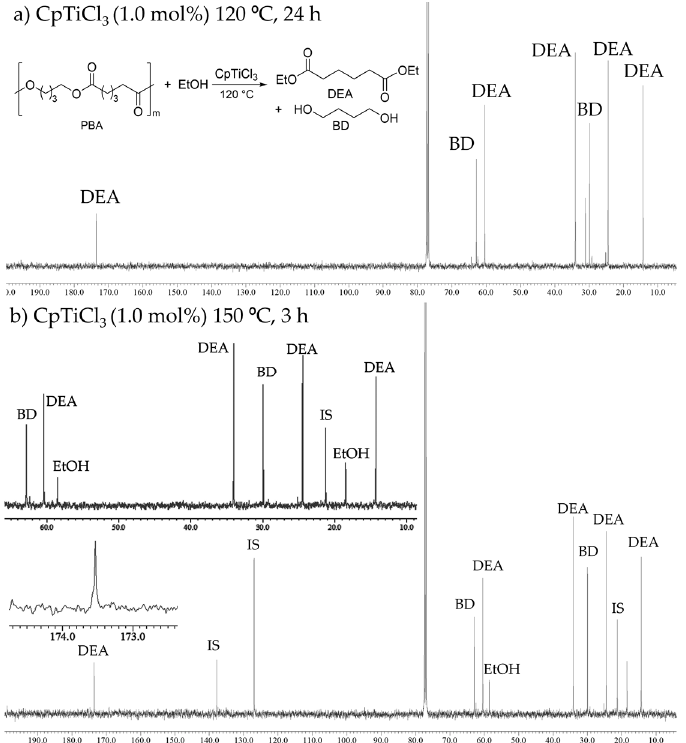
Figure 2. 13 C NMR spectra (in CDCl 3 at 25 °C) for transesterification of poly(butylene adipate) (PBA) with ethanol by CpTiCl 3 (1.0 mol%). Conditions: ( a ) 120 °C 24 h, ( b ) 150 °C 3 h (run